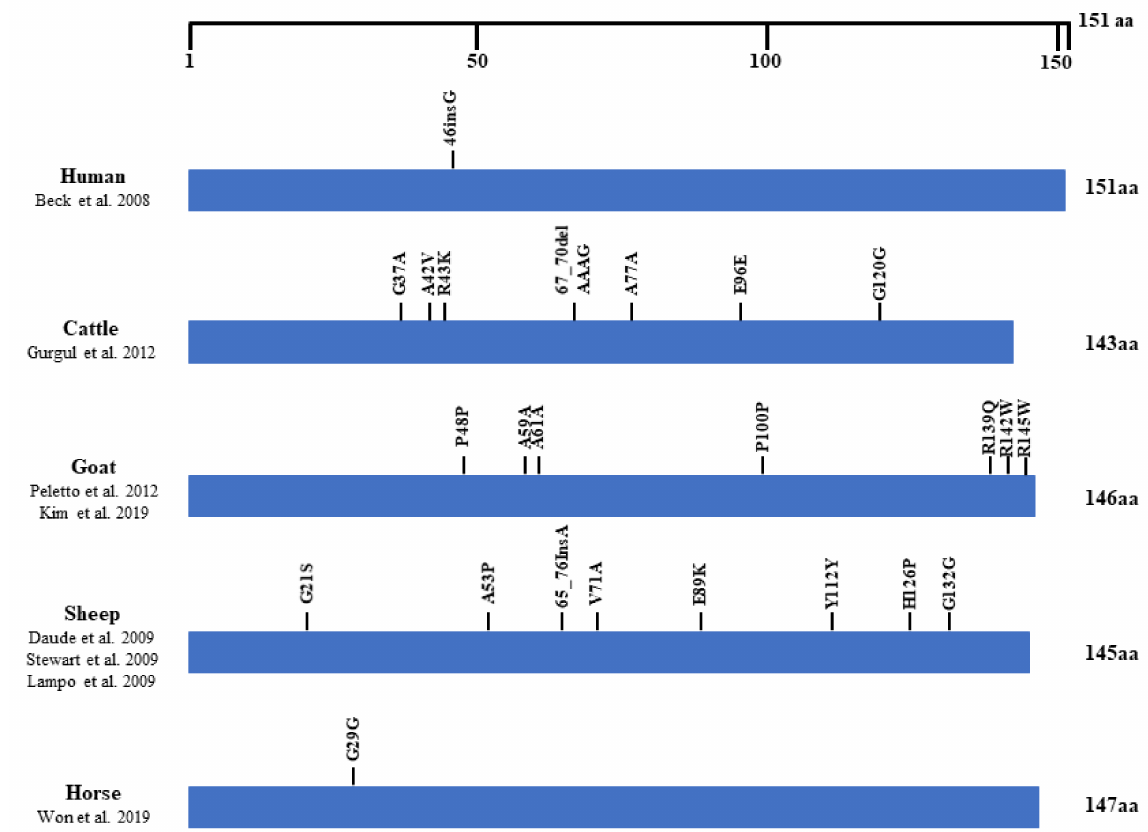
Figure 4. Distribution of polymorphisms in the open reading frame (ORF) of the shadow of the prion protein gene ( SPRN ) in various species. The figure shows the previously reported genetic polymorphisms of the SPRN gene in humans, cattle, goats, sheep and horses. The edged horizontal bar indicates the length of the amino acids in the SPRN gene